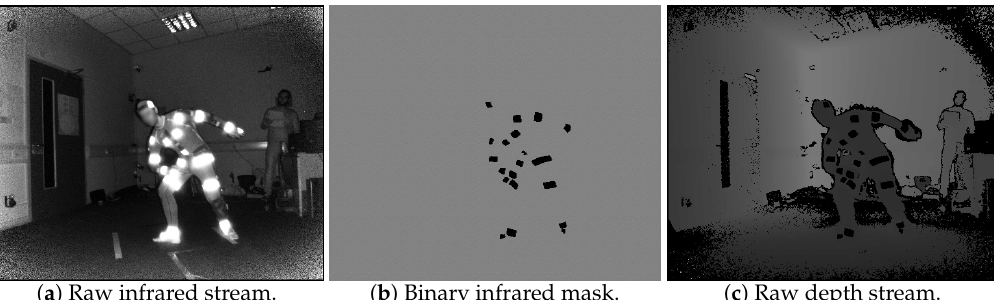
Figure 3. Raw depth and infrared data.